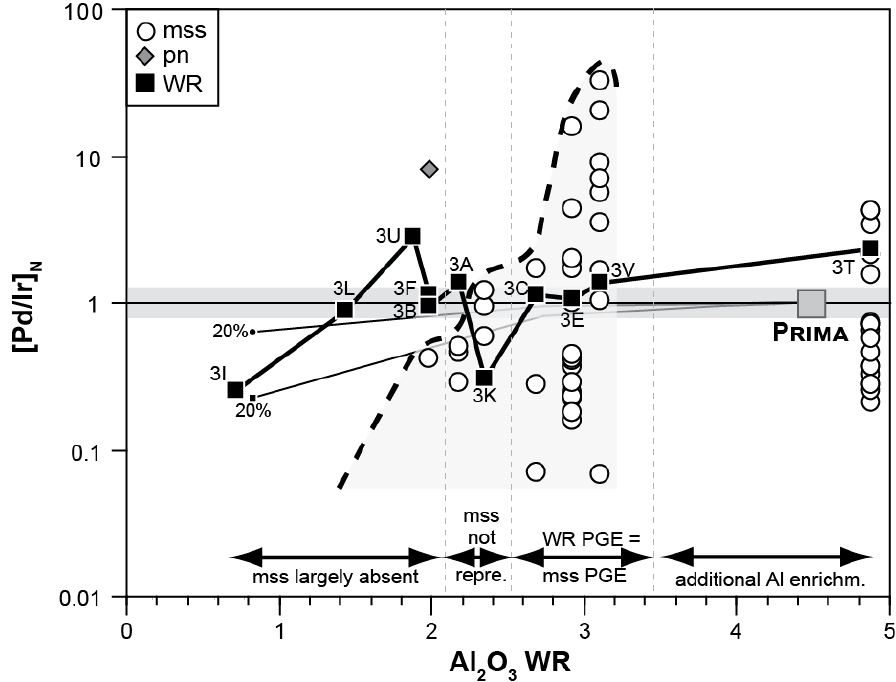
Figure 8. Relationship of [Pd / Ir] N in sulfides (mss: open circle; pentlandite: filled rhombs) and whole-rock [Pd / Ir] N -Al 2 O 3 in their host xenoliths (black squares; Wittig et al. [20]), highlighting that refractory peridotites with low bulk Al 2 O 3 contents (Atl-3I, -3L, -3U, -3F) do not comprise a substantial sulfide population. In xenoliths Atl-3A and -3K, the investigated sulfides do not seem to represent the whole-rock PGE systematics, while with increasing bulk Al 2 O 3 content ( > 2.5 wt %), sulfides become more representative of the whole-rock PGE systematics (Atl-3C, -3E, -3V). In addition, the range of [Pd / Ir] N of the sulfides systematically increases from infertile to fertile xenoliths (dashed gray field). Sulfide and whole-rock [Pd / Ir] N are correlated with whole-rock Al 2 O 3 content, confirming the conclusion of Wittig et al. [20] that the Middle Atlas subcontinental lithospheric mantle (SCLM) probably experienced coupled introduction of sulfides and Al-bearing phases (i.e., clinopyroxene, amphibole; see above). Sample Atl-3T exceeds the primitive mantle (PRIMA) Al 2 O 3 content, while its range in sulfide [Pd / Ir] N is more comparable to Atl-3E, suggesting that lithophile elements in this sample experienced more vigorous metasomatic enrichment relative to other xenoliths, which is consistent with its clinopyroxene modal abundances and trace element and isotope data [20,30]. Also shown are two PGE-Al 2 O 3 melting models [20,24,66], which are based on a PRIMA S content of 250 ppm [40] and rely on sulfide mineralogy and fractional melting equations [67]. These models di ff er in the presumed Pt / Pd KD , which was set to 0.4 and 0.7 (see Figure 9).